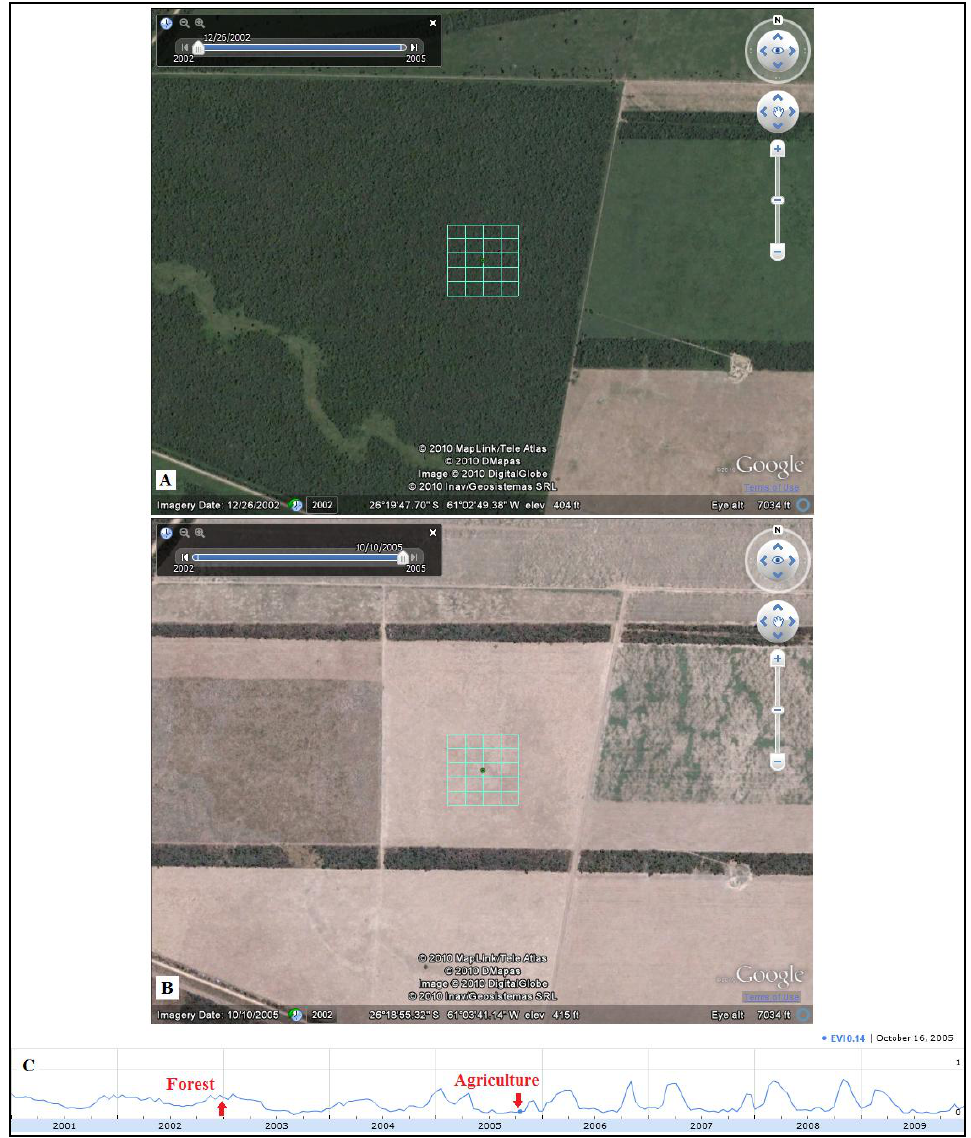
Figure 9. Example of the historical imagery time slider within VIEW-IT’s Google Earth window for a sample near Pampa del Infierno, Argentina (panels copied from VIEW-IT’s interface). (A) Image in December, 2002 shows the sample as dry forest. (B) Image in October, 2005 shows the sample area converted to agriculture (likely soybeans). (C) The VIEW-IT Enhanced Vegetation Index (EVI) profile for the sample shows the seasonal cycle of dry forest up until year 2004, followed by an agricultural cycle with low EVI values from exposed bare soil after harvest in the dry season. Red arrows indicate the image dates in images (A) and